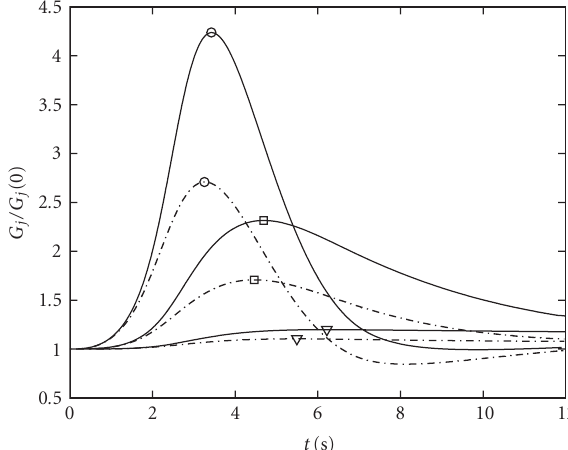
Figure 6: Precursor concentration evolution in the presence of a moving fissile lump evaluated with point kinetics coupled with a thermal feedback model. The stabilizing role of feedback is clearly visible.